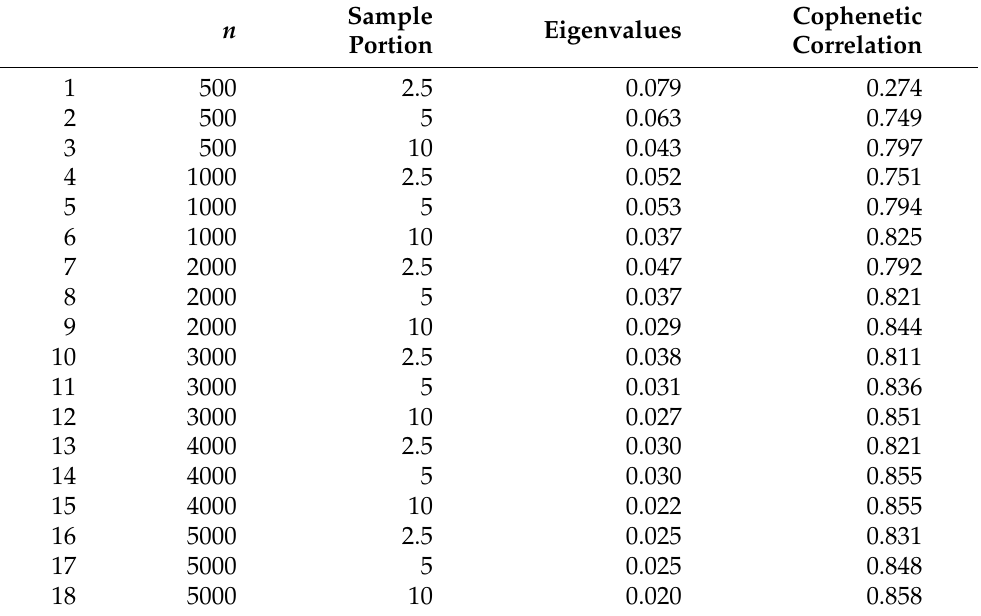
Table 5. Discrepancies through eigenvalues (MSE) and Euclidean configurations (cophenetic